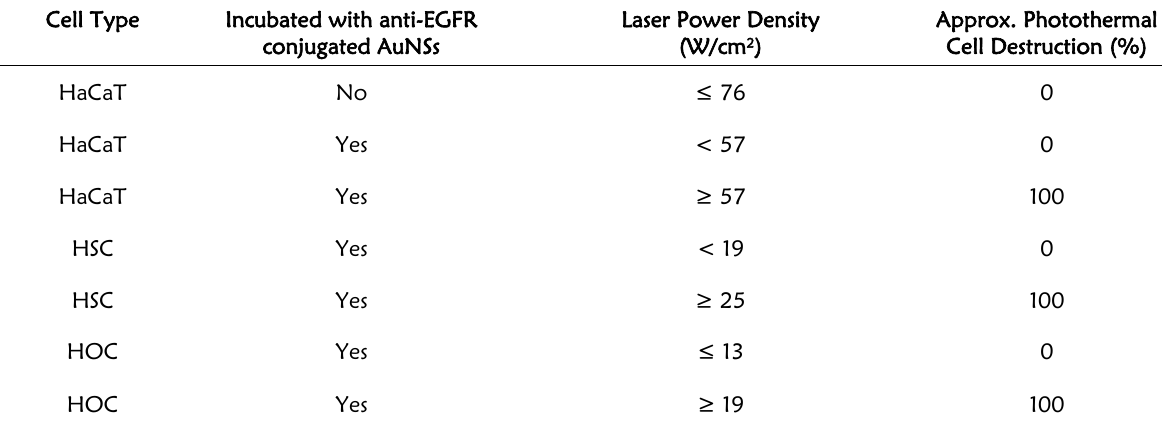
Table 2: Photothermal Cell Destruction Results by Cell Type and Laser